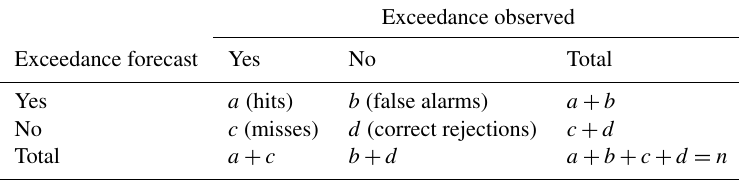
Table E1. Schematic contingency table for deterministic forecasts of binary exceedances of the regulatory limit values.